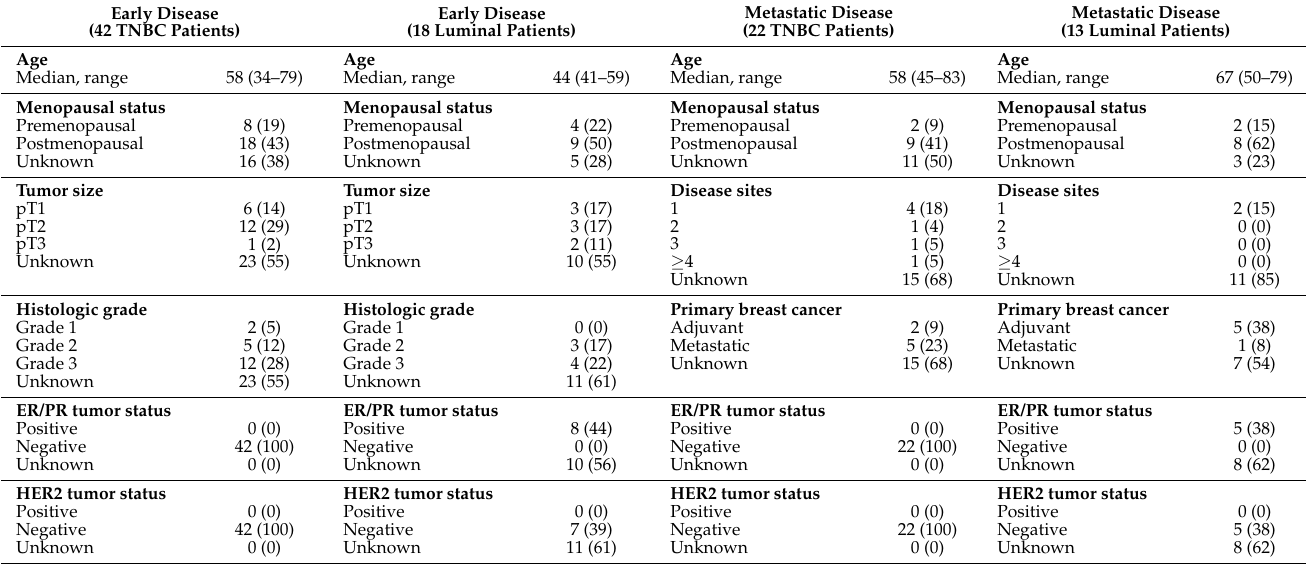
Table 1. Patients’